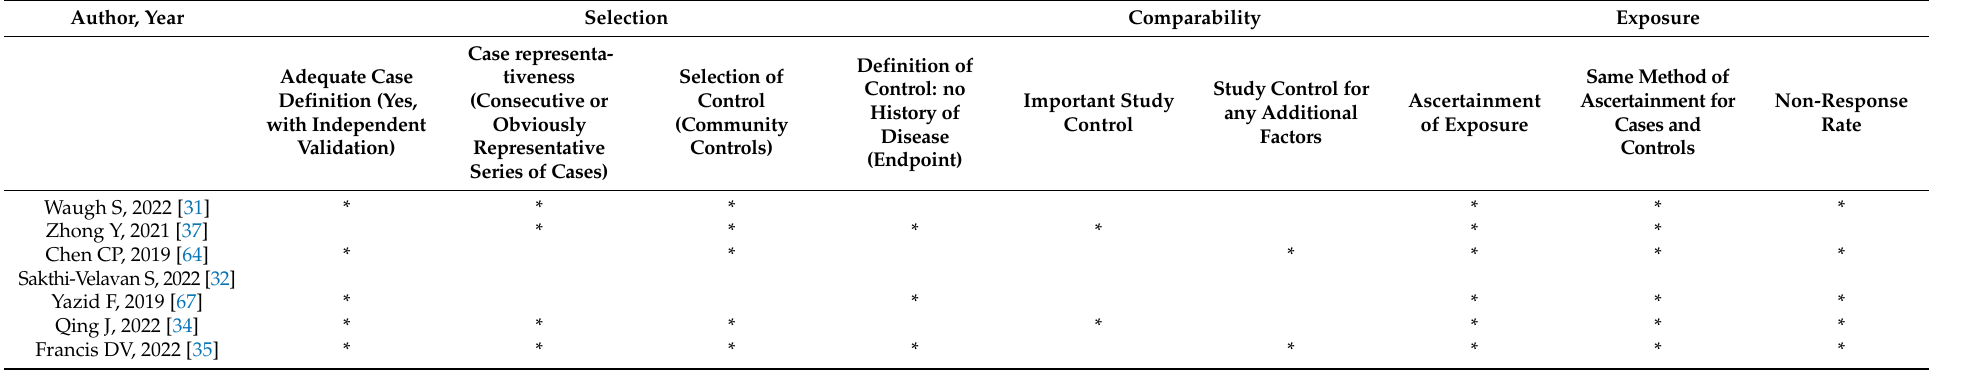
Table 5. Summary of quality assessment of case–control studies using the NOS